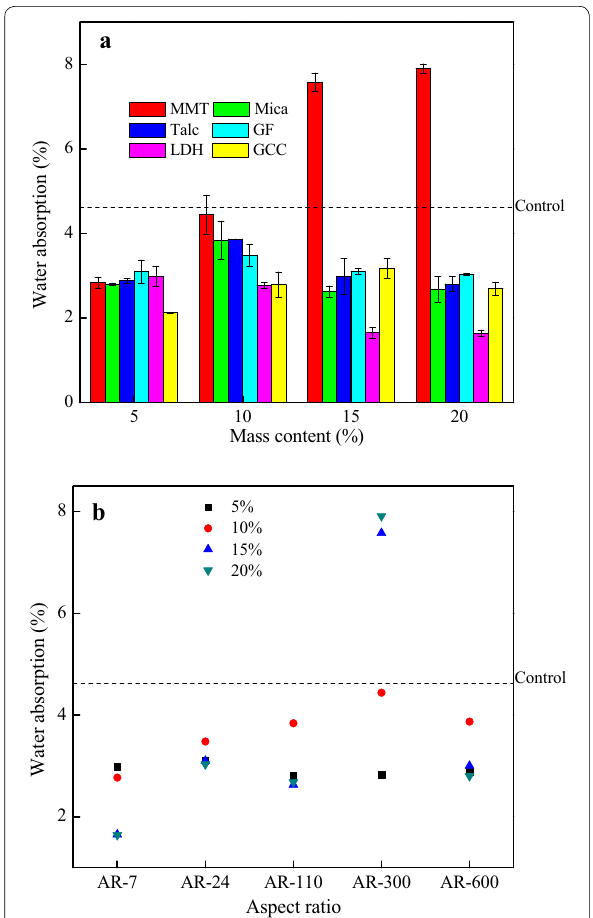
Fig. 4 Water absorption of modified EECM with different fillers. a Filler contents; b aspect ratios of